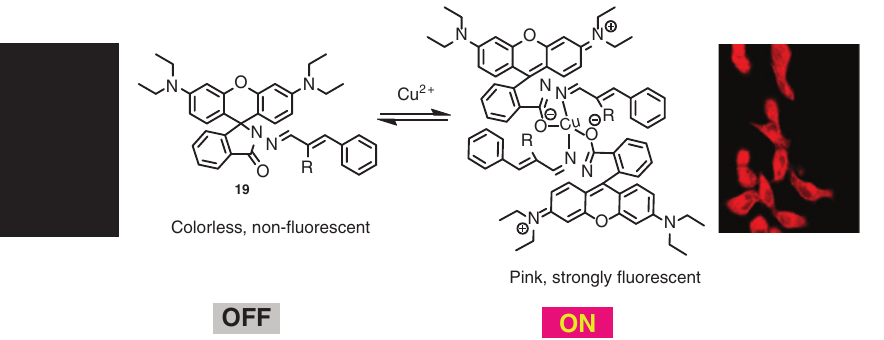
Figure 15: Proposed mechanism for the fluorescent changes upon the addition of Cu 2 + and fluorescent images of HeLa cells incubated with probes. Reprinted from Yang et al.